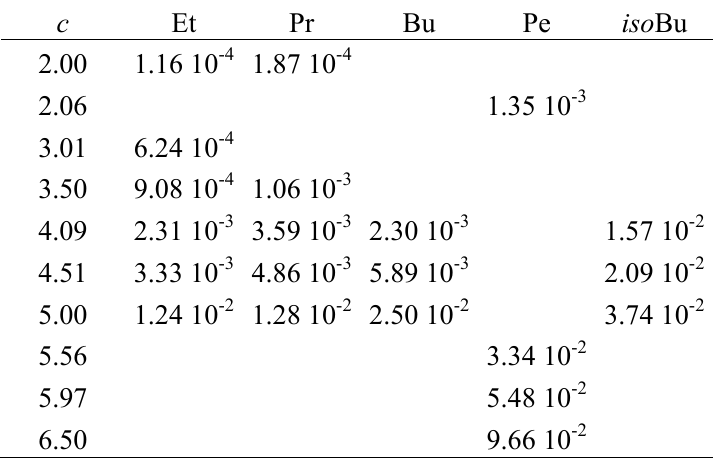
(s –1 ) of the second kinetically Table III Values of observed rate constants k obs measurable step of acid-catalysed hydration of α -alkylstyrenes depending on sulphuric acid concentration c (mol·dm –3 ) in water at 25 °C, for the wavelengths λ (nm) at which the measurements were carried out, see Table